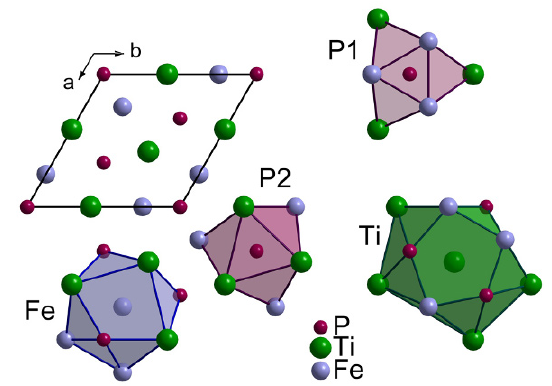
Figure 3. Projection of TiFeP structure on the ab -plane and coordination polyhedra of the atoms.